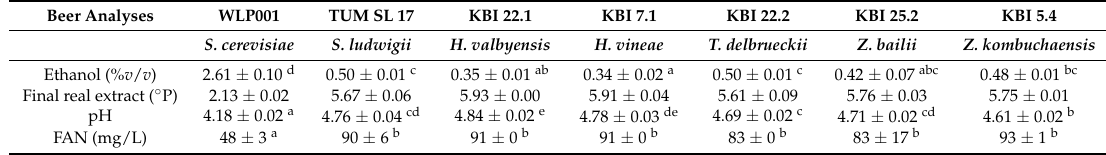
Table 4. Analysis of final beers after fermentation with investigated